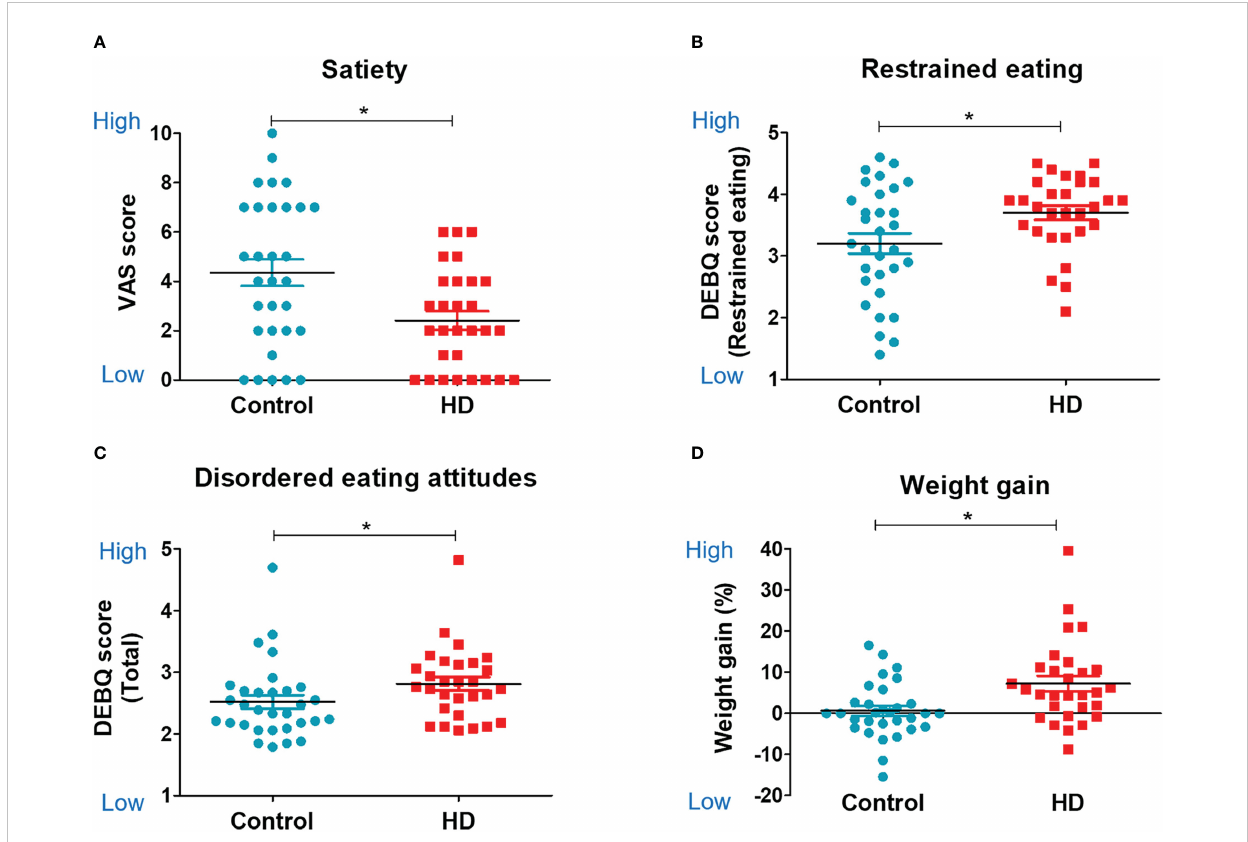
FIGURE 2 Food-related psychology, eating behavior, and weight change. Scatter plots for food-related psychology, behavior, and weight change in the hypothalamic damage (HD) and control groups. The unpaired, two-sample Student ’ s t -test was used for comparing the HD and control groups. (A) Visual analog scale score of satiety. (B) Restrained eating subscale of DEBQ (Dutch Eating Behavior Questionnaire). (C) Total score of DEBQ. (D) Weight gain %. * indicates signi fi cance (P<0.05).